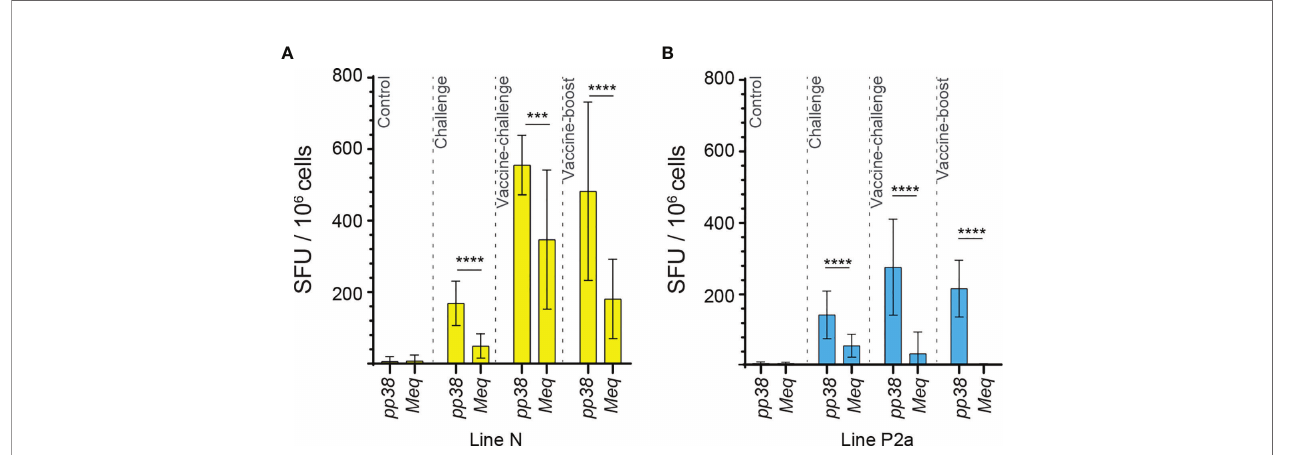
FIGURE 4 | High frequencies of IFN-gamma producing T cells are detected against pp38 compared to MEQ in the experimental groups of both chicken lines at 2 weeks post the last inoculation. The frequencies of IFN-gamma producing T cells recognizing MEQ and pp38 -derived peptide pools, detected using an ex vivo chIFN-gamma ELSIPOT assay, are shown in (A) line N (yellow) and (B) line P2a (blue) chickens at 2 weeks post inoculation within the experimental groups. The results are presented as SFU per 10 6 cells and shown as mean ± SD. Non-parametric Wilcoxon tests (Mann – Whitney) was used to assess normal distribution and test signi fi cance. *** ( P ≤ 0.005) and **** ( P ≤ 0.001) indicates as statistically signi fi